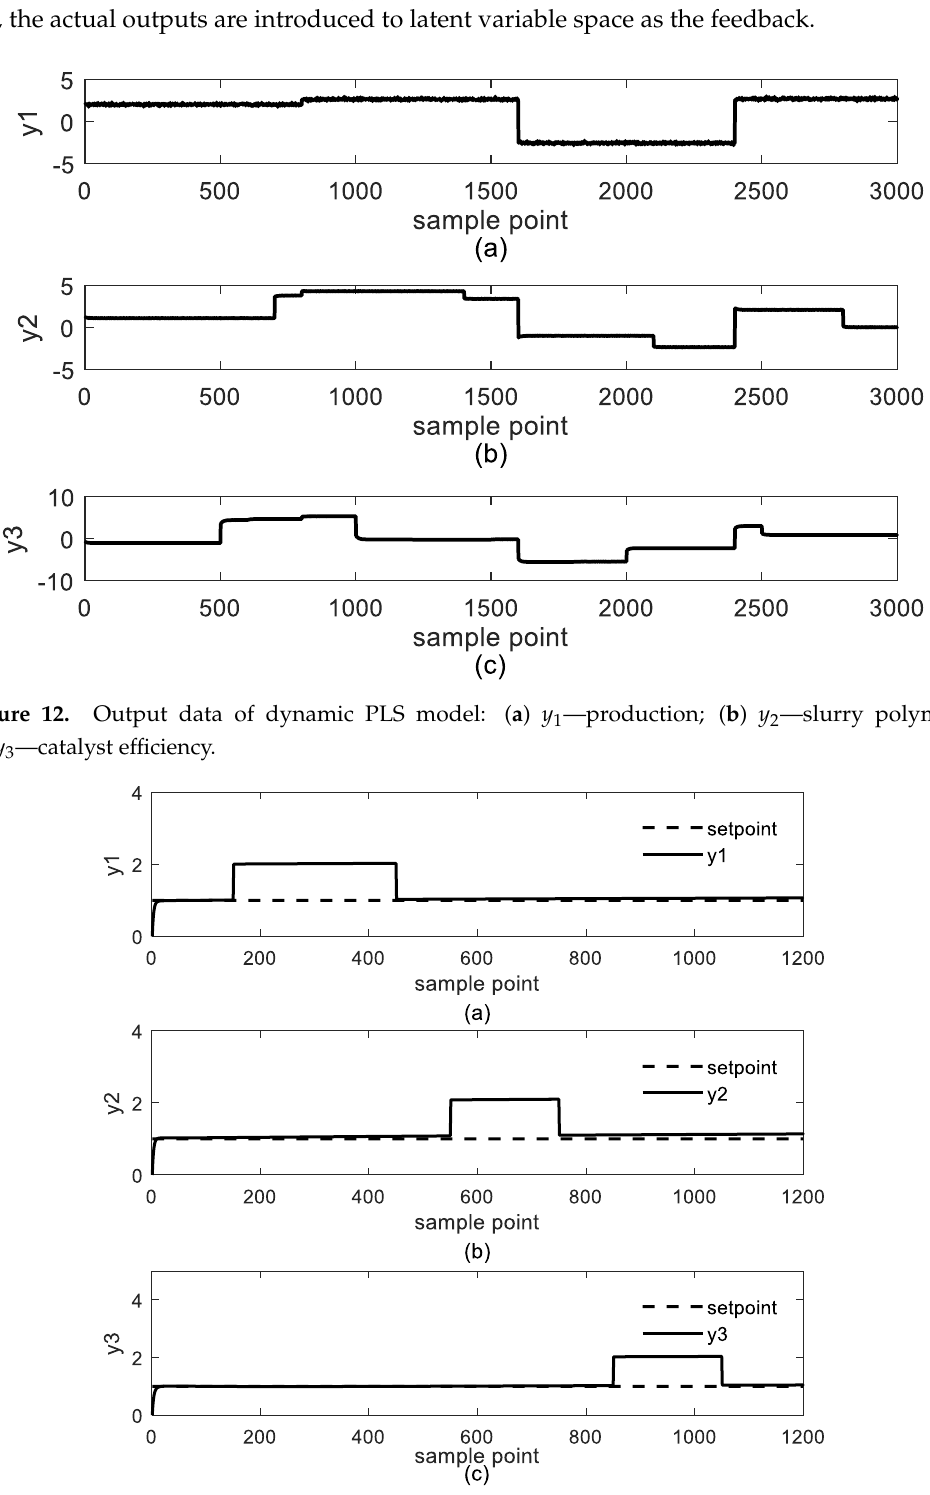
Figure 14. The simulation result of OSDP1 without noise: ( a ) y 1 —production; ( b ) y 2 —slurry polymer; ( c ) y 3 —catalyst efficiency.